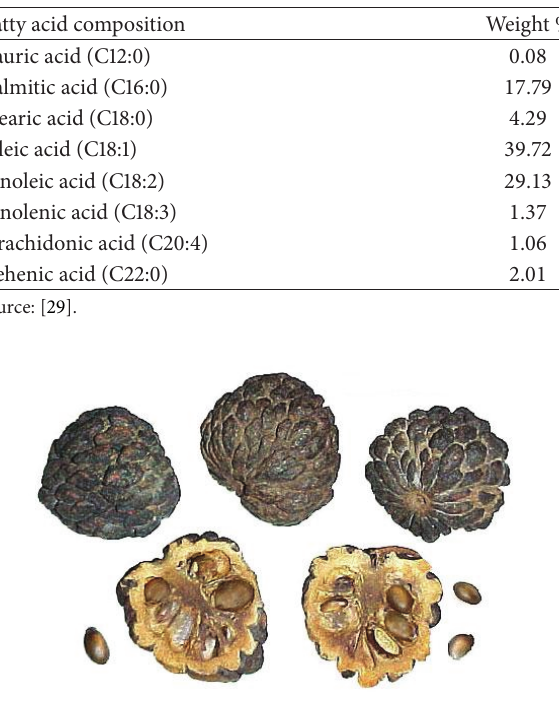
Figure 1: Sugar apple ( Annona squamosa ) fruits and seeds.